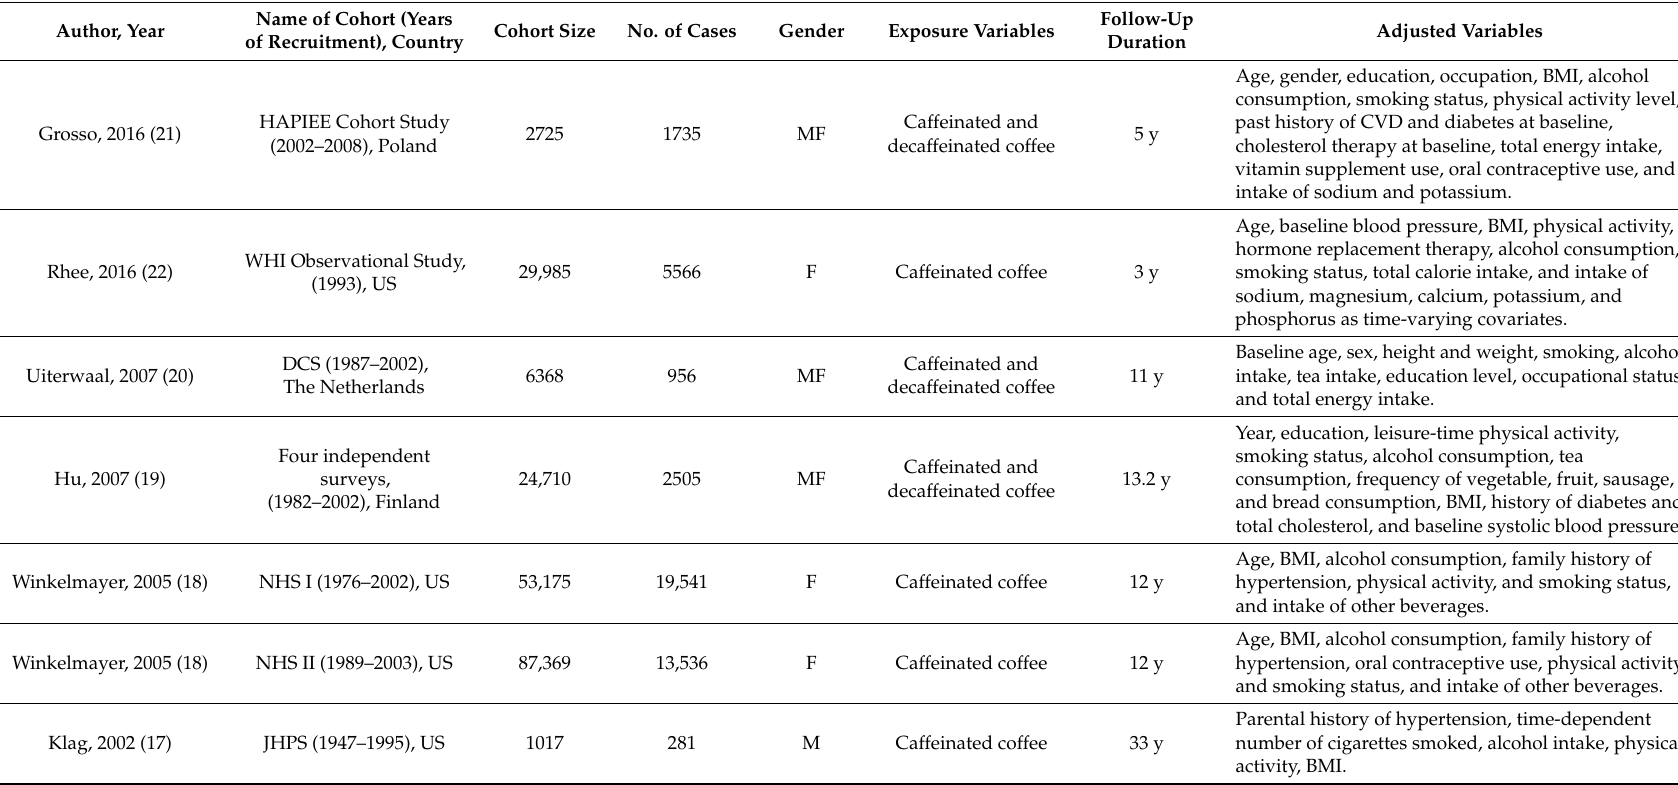
Table 1. Main characteristics of prospective cohort studies investigating the association of coffee consumption and risk of